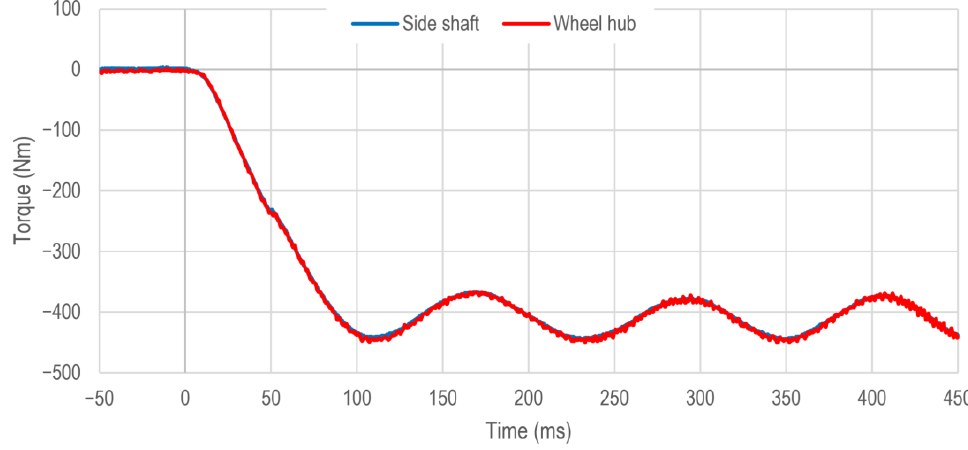
Figure 10. Regenerative braking operation from 25 km/h with activated prefilter and deactivated anti-jerk control.